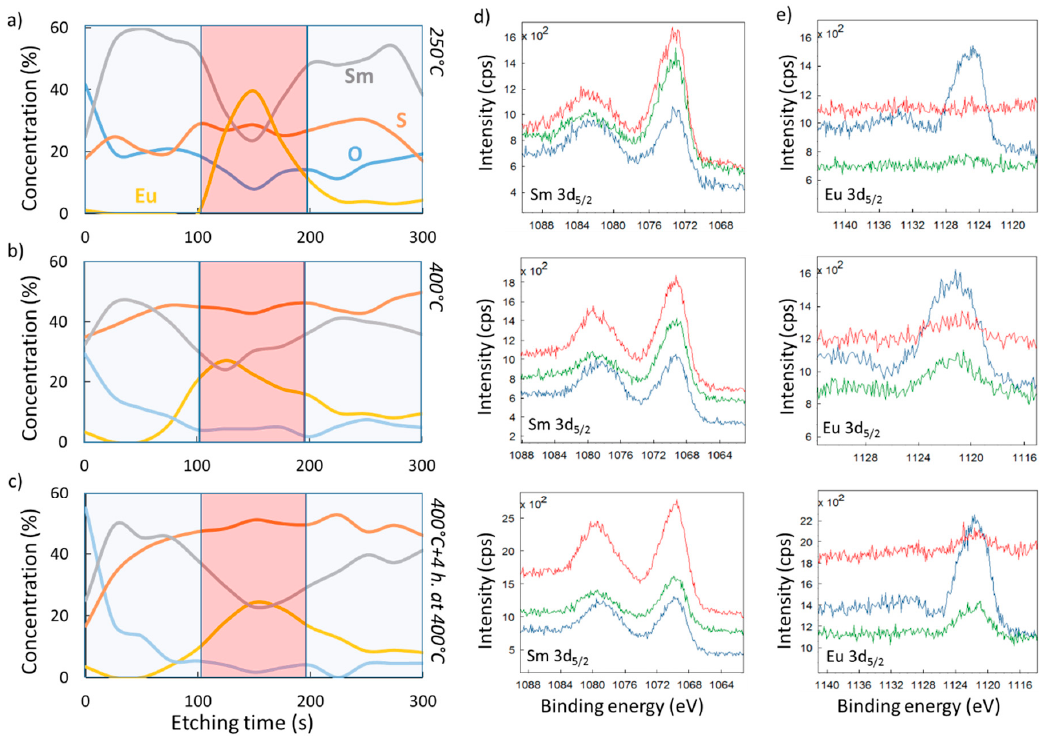
Figure 7. XPS depth profiling analysis of an as-deposited 35 / 30 / 35 nm SmS / EuS / SmS tri-layer system, deposited 250 ◦ C ( a ), deposited at 400 ◦ C ( b ), and after 4 h post-deposition annealing at 400 ◦ C ( c ). ( d ) Sm 3d 5 / 2 photoelectron peaks for the fabricated samples in Figure 7a,c, from top to bottom, respectively. ( e ) Eu 3d 5 / 2 photoelectron peaks, as in ( d ). In both ( d ) and ( e ), the red curve corresponds to the photoelectron spectra after 25 s of sputtering, the navy one to 150 s, and the green curve to the sputtering time of 275 s.